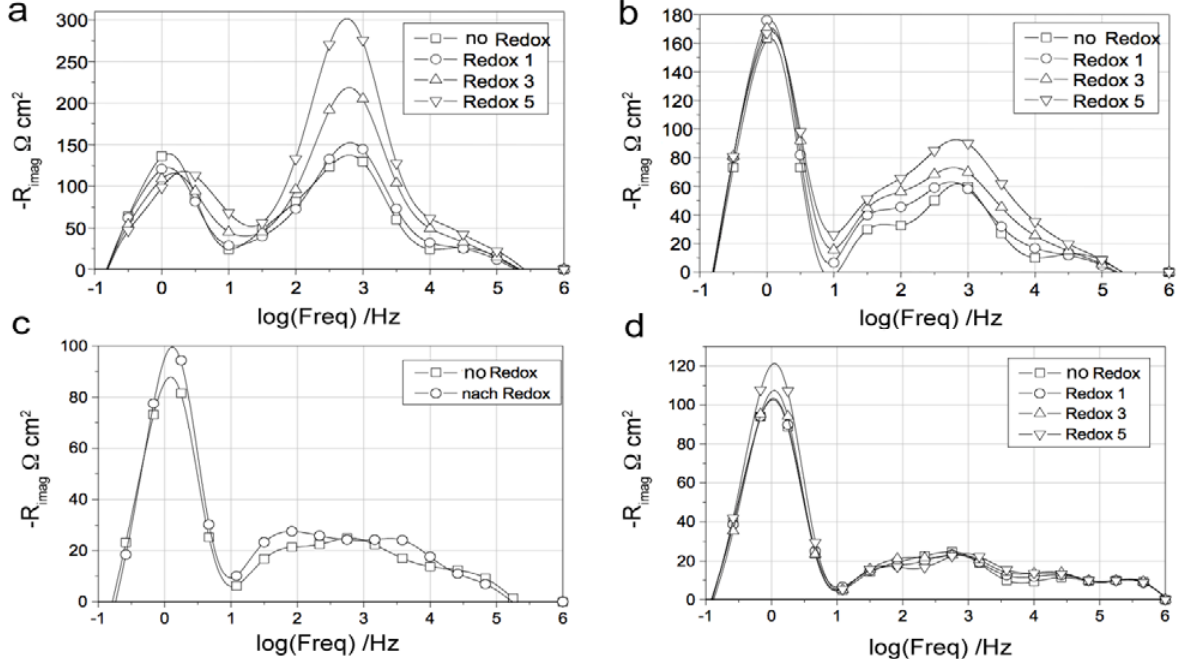
Figure 26. Electrochemical impedance spectroscopy at open circuit voltage (OCV), of electrolyte supported cell after RedOx treatments at 950 °C of sample composition ( a ) A; ( b ) B; ( c ) C and ( d ) D described in Table 6